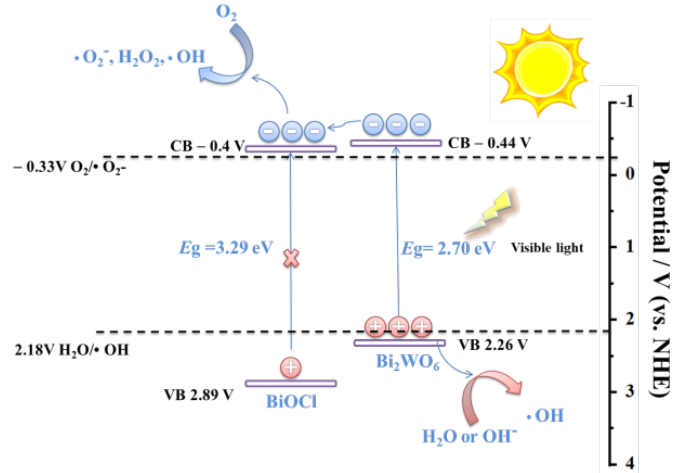
Figure 8. Possible photocatalytic mechanism of BWOC2.